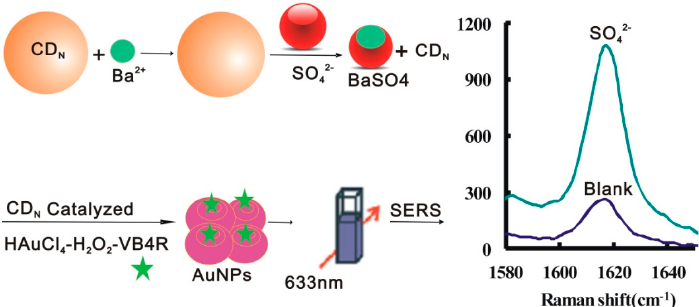
Figure 1. Surface enhanced Raman scattering (SERS) determination of sulfate by BaSO 4 regulation of CD N catalysis of the gold nanoreaction between HAuCl 4 and H 2 O 2 .